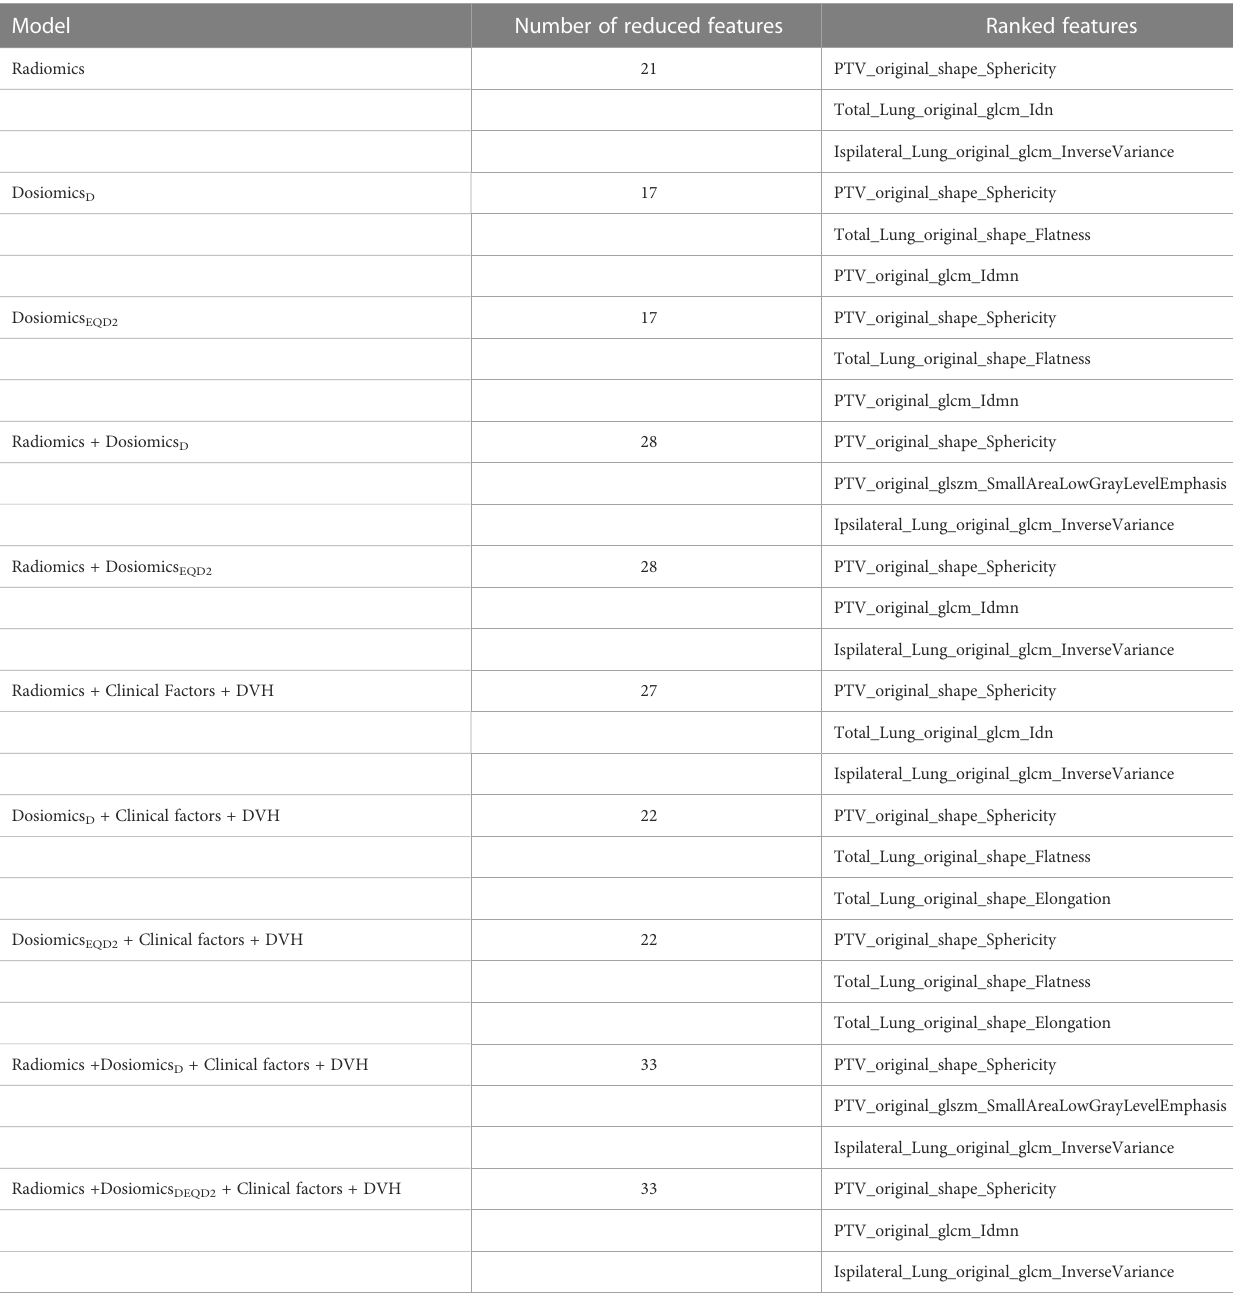
TABLE 2 Features ranked in the order of frequency they have been selected after feature reduction for all models